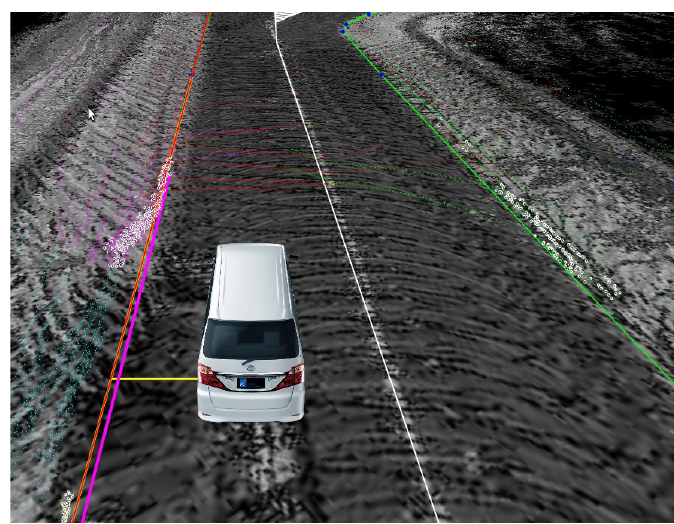
Figure 3. Curb estimated by fitting.